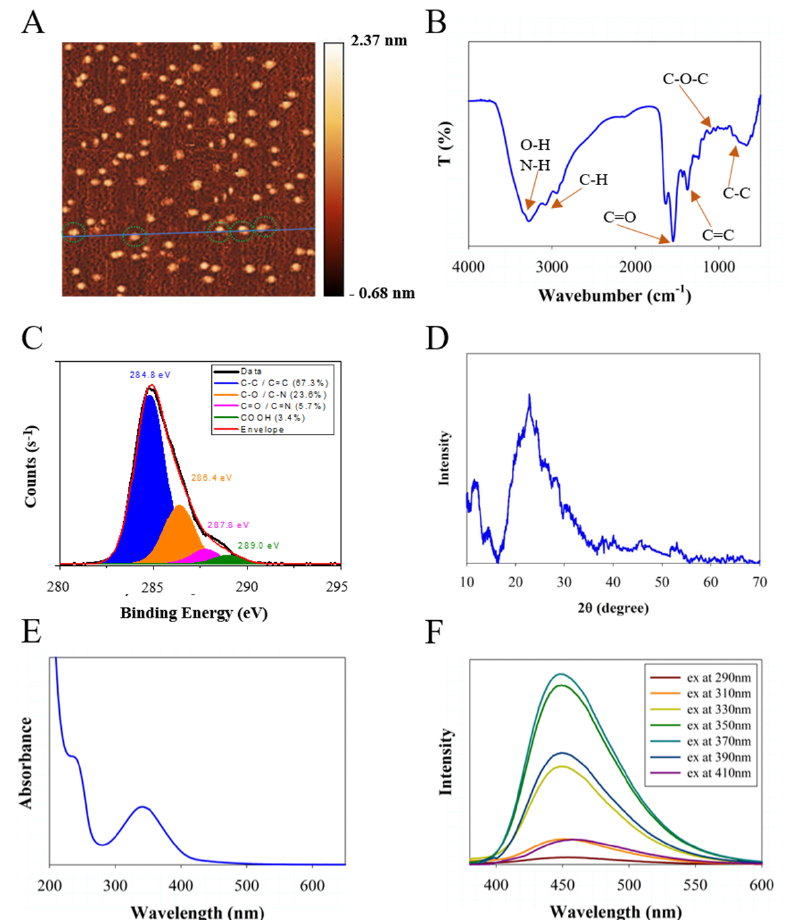
Figure 1. CNDs characterization: ( A ) AFM topography image, ( B ) FTIR spectra, ( C ) XPS signal (C 1s), ( D ) XRD data, ( E ) UV − Vis absorption spectra, and ( F ) fluorescence emission spectra.